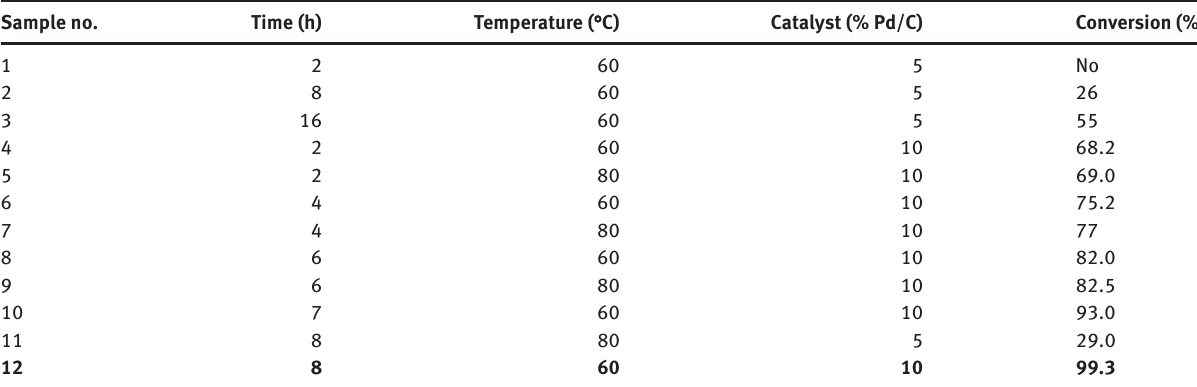
Table 2: Optimisation of reaction conditions for the preparation of 2-hydroxy-5-amino benzoic acid (1). Sample